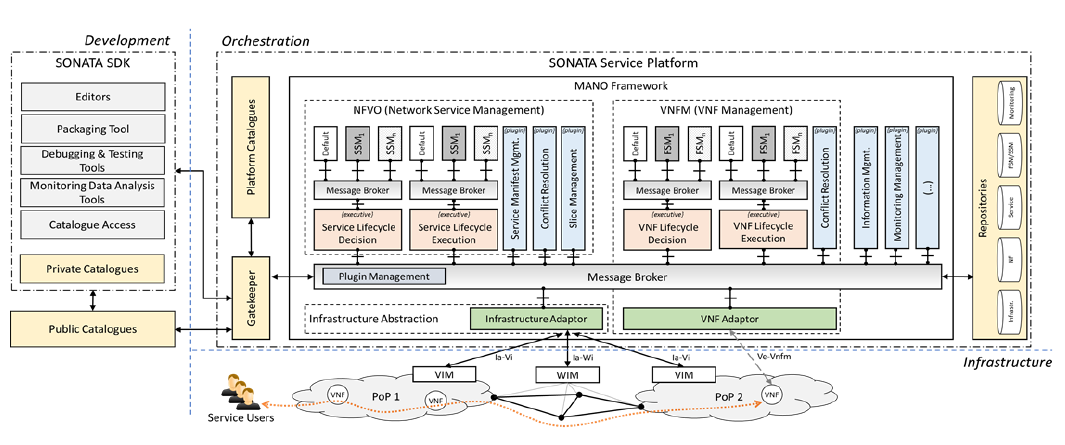
Figure 2. SONATA architecture diagram